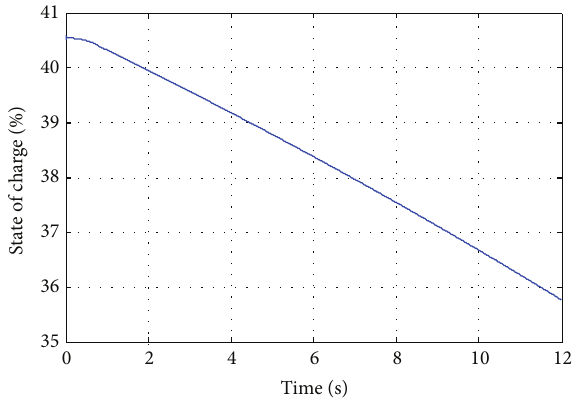
Figure 9: Evolution of the SOC in the different phases.